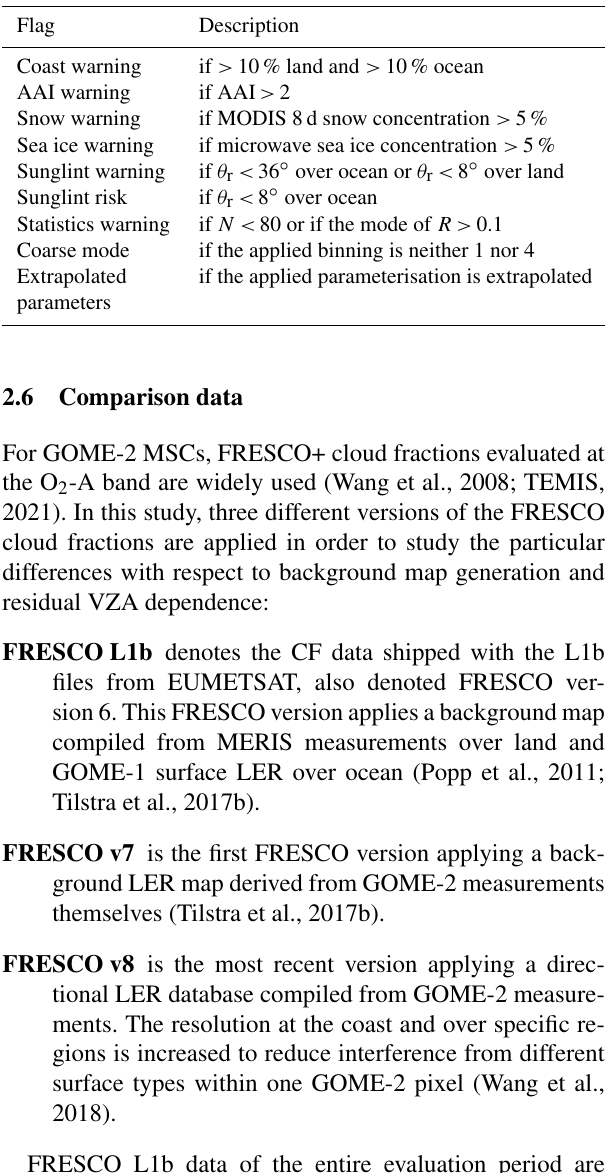
Table 7. Flags applied by the MICRU algorithm allowing for indi- vidual